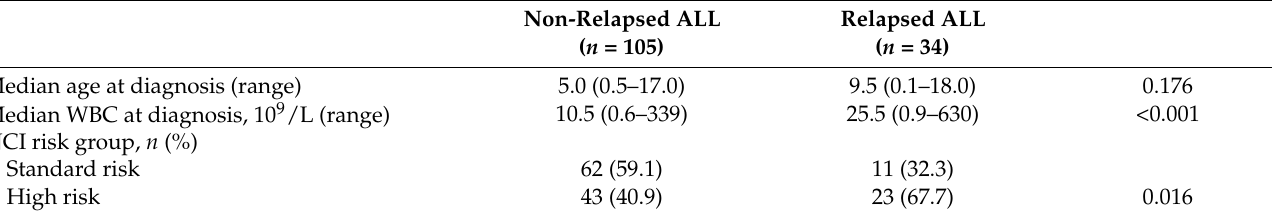
Figure 4. The change in mutational distribution of the study cohort at the time of diagnosis and relapse. Table 1. Comparison of clinical characteristics between non-relapsed and relapsed ALL.